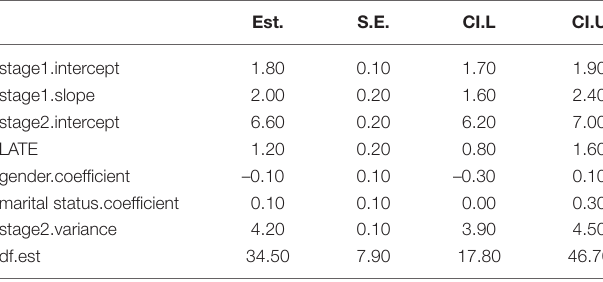
TABLE 3 | Parameter estimates for the voucher program